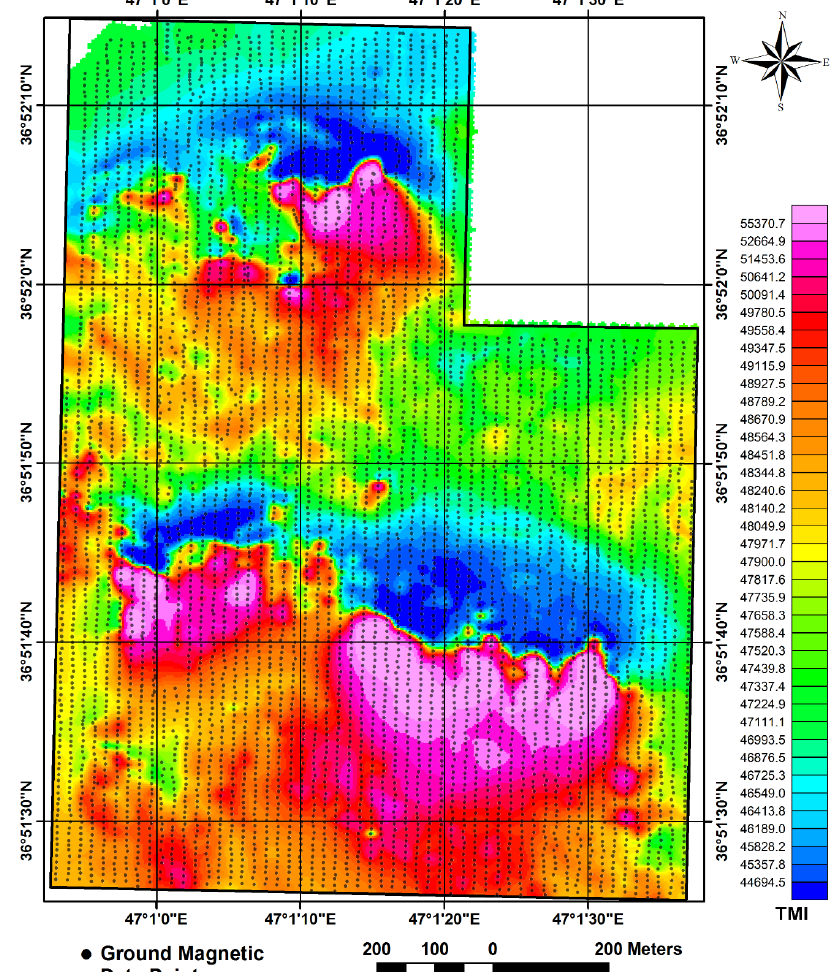
Figure 2. TMI map of Qoja-Kandi with ground magnetic data